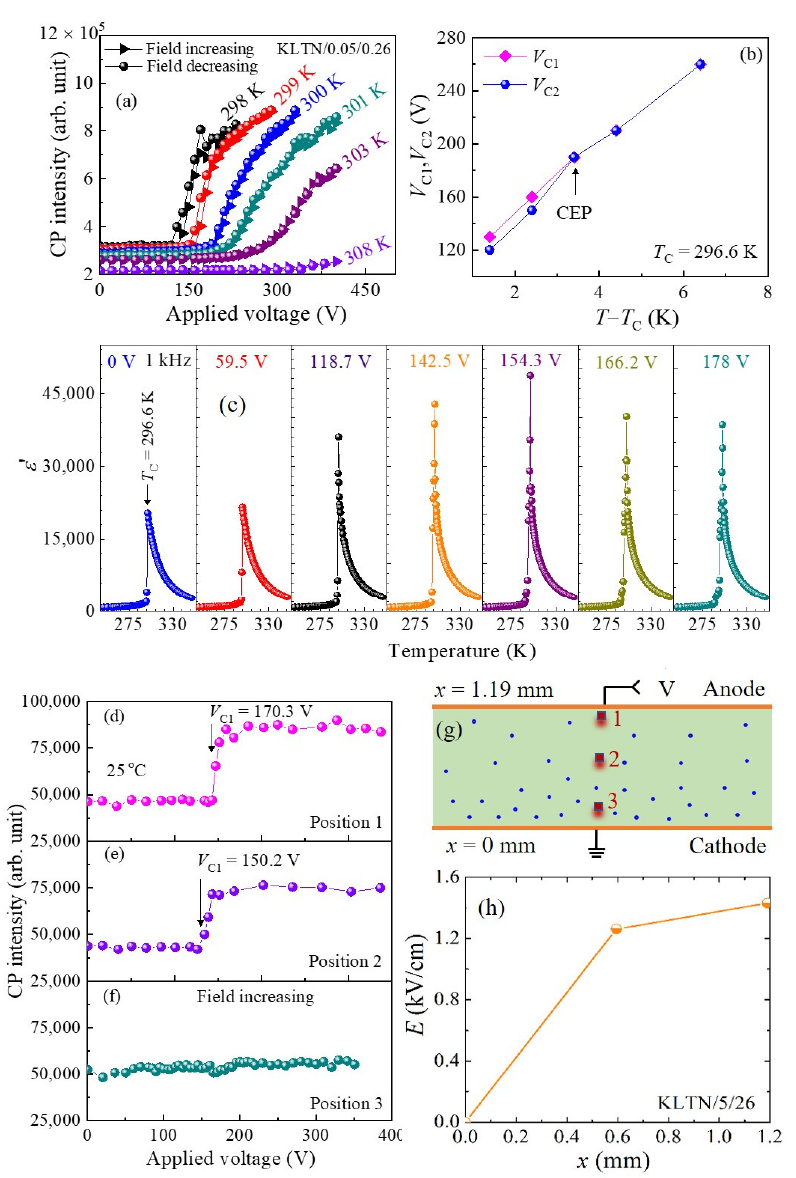
Figure 11. ( a ) The CP intensity of the KLTN/0.05/0.26 crystal at some selected temperatures as a function of applied voltage. ( b ) Temperature dependence of critical electric voltages of a phase transition, where V C2 denotes the transition from ferroelectric to paraelectric and V C1 indicates the transition from paraelectric to ferroelectric phase. ( c ) The dielectric constants of the KLTN/0.05/0.26 crystals measured at 1 kHz under the DC biasing voltages as a function of temperature. The electric voltage dependence of the observed CP intensity at ( d ) close to the anode (position 1), ( e ) close to the center (position 2), and ( f ) close to the cathode (position 3). The three positions in the KLTN/0.05/0.26 crystal are schematically drawn in ( g ). ( h ) The critical electric field of the KLTN/0.05/0.26 crystal as a function of position. The data were adapted from Ref. [116].